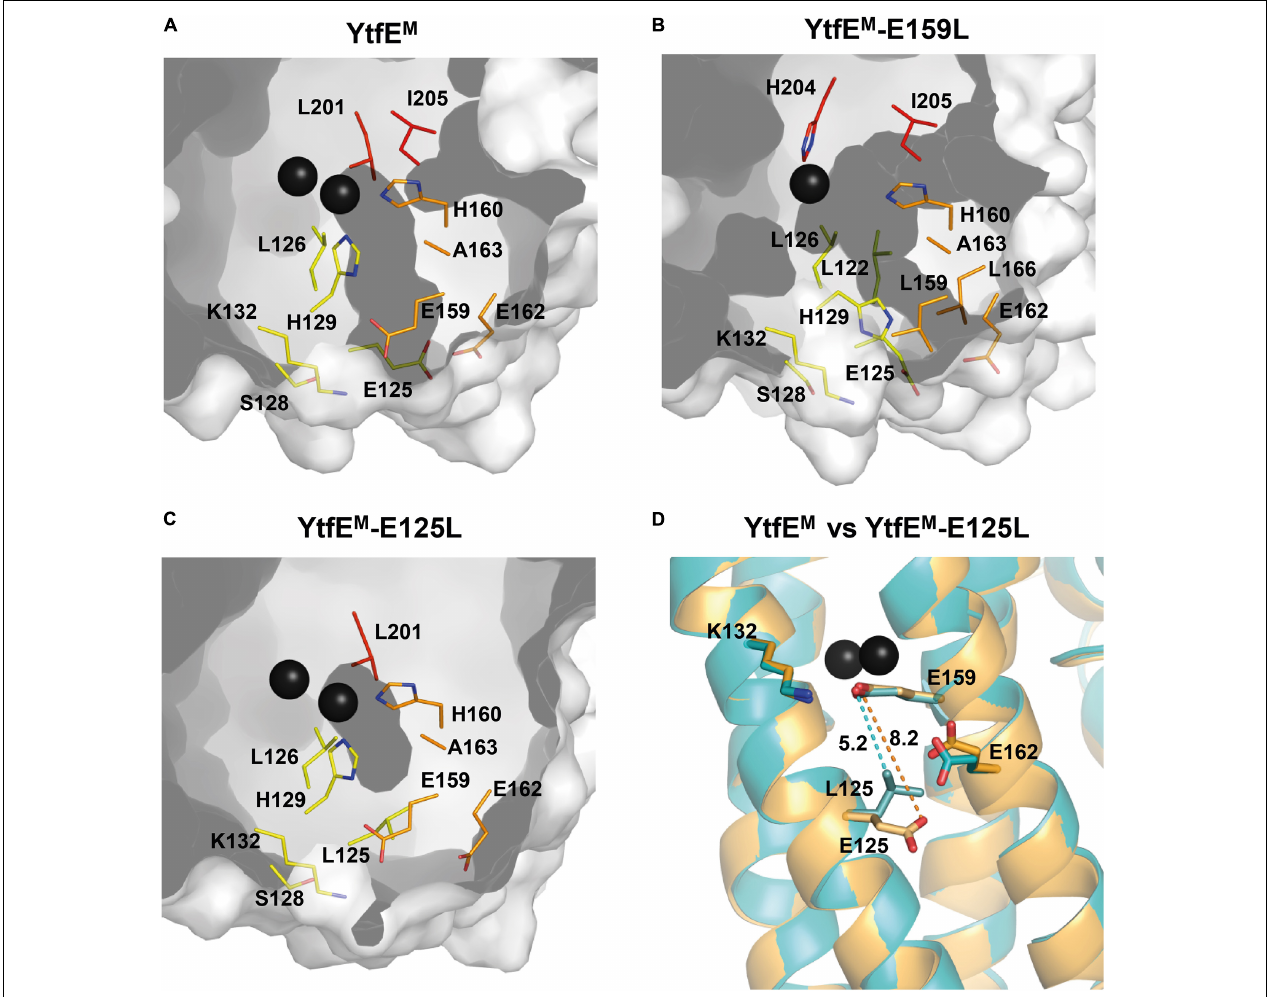
FIGURE 5 | Channels present in YtfE M and YtfE M -E159L structures. Channels are represented in dark gray. Residues lining the iron channel are represented as sticks with carbon atoms rainbow colored according to the helices (helix 2 – yellow, helix 3 – orange, and helix 4 – red). (A) YtfE M iron channel connects the external surface to the di-iron site. YtfE M has its channel entrance formed by residues E159, E162, E125, and K132. (B) In YtfE M -E159L, the channel connects the external surface to the mononuclear iron center, and has its entrance between residues E162, L166, and E125, i.e., slightly below that of the YtfE M pore. (C) No channels are observed in the YtfE M -E125L structure. A small cavity occurs near the di-iron center, however, the channel is interrupted by mutation of E125 to leucine. (D) Superposition of the YtfE M (orange) and YtfE M -E125L (cyan) structures showing the distances between the residues involved in the channel entrance. Distance between YtfE M residues 159 and 125 is represented by a dashed orange line whereas the distance between YtfE M -E125L residues is indicated by a dashed cyan line. The channels were modeled using MOLE (Sehnal et al., 2013) and PyMOL (DeLano, 2020)